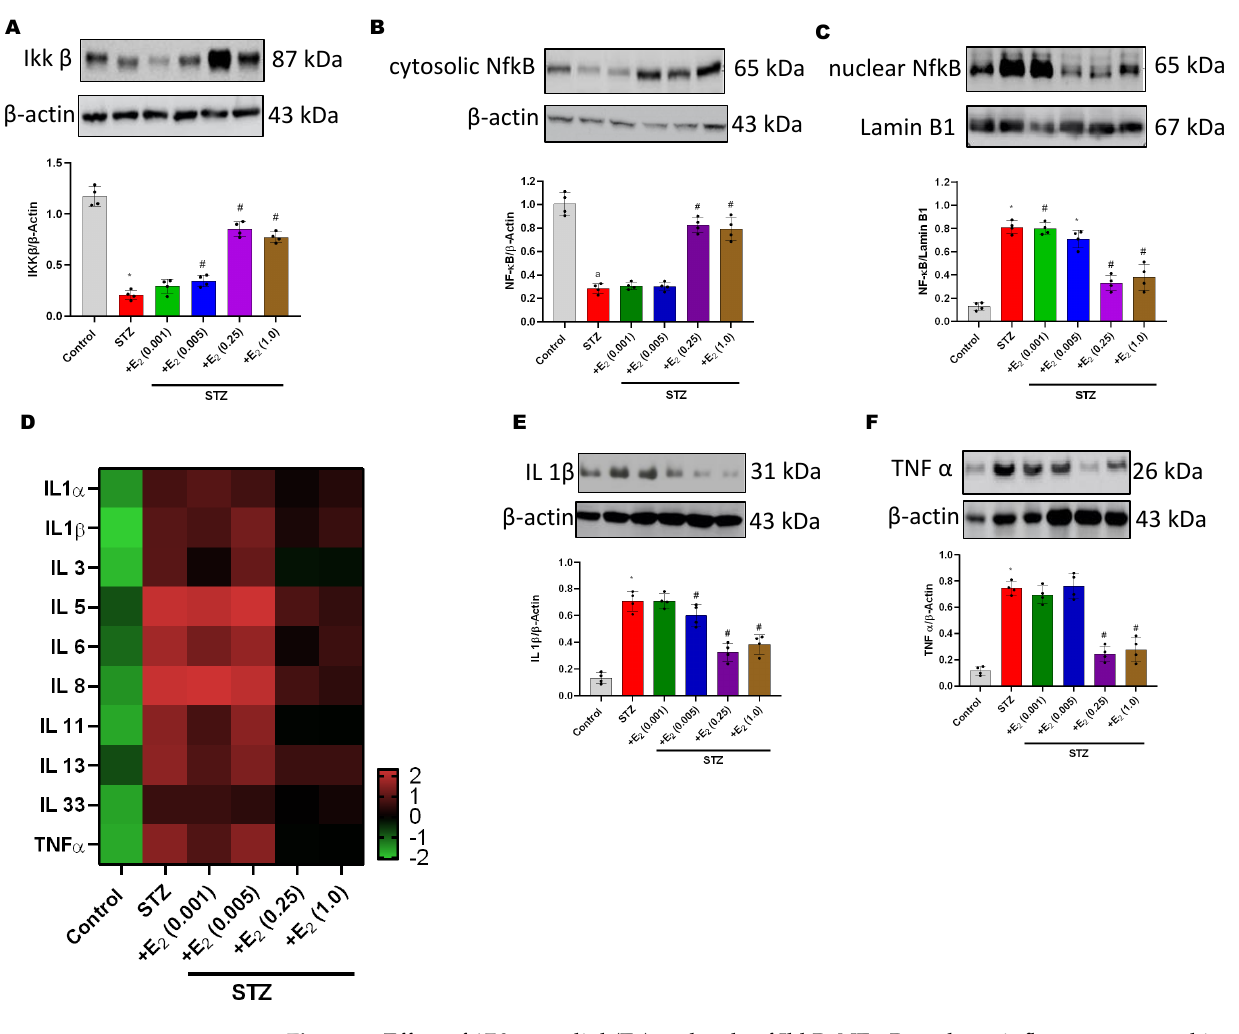
Figure 5. Effect of 17 β -estradiol (E 2 ) on levels of IkkB, NF- κ B, and pro-inflammatory cytokines in STZ-induced diabetic mice. Representative immunoblot and densitometry analysis for IkkB ( A ), cytosolic and nuclear NF- κ B ( B , C ), Heat map of differentially expressed inflammatory genes in control, STZ, and STZ mice receiving various doses of 17 β -estradiol (E 2 ) supplementation ( D ), IL-1 β ( E ), and TNF α ( F ) in gastric neuromuscular tissues are presented. Stripped blots were re-probed for β -actin. Data for target proteins were normalized to protein levels of β -actin. Bar graphs depict ratios of levels of target proteins to those of β -actin. Data are presented as the average fold change of four mice per group at 9-week time point analyzed. Data were analyzed with one-way ANOVA using GraphPad Prism. Data are means ± SEM ( n = 4). * ,a denotes p < 0.05; significantly different from healthy mice (Con). # denotes p < 0.05; significantly different from STZ-induced diabetic mice (STZ). Legends: inhibitor of nuclear factor kappa B kinase subunit beta (IkkB), nuclear factor